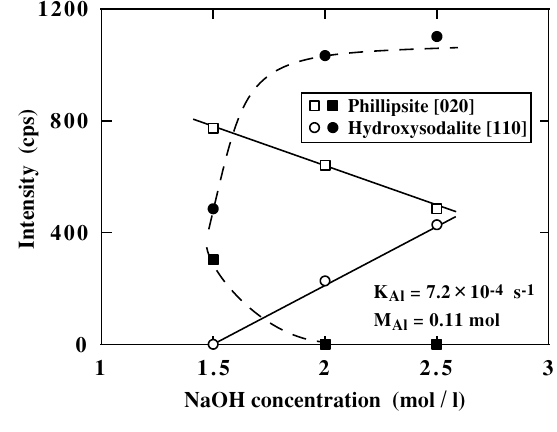
Fig. 8 XRD peak charts for products treated with various NaOHaq. con- centrations (K Al = 7.2 × 10 - 4 s - 1 , K Si = 2.0 × 10 - 5 s - 1 , M Al = 0.11mol, M Si = 0.12mol, Treatment time = 12hr).